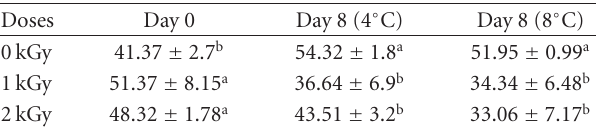
Table 1: E ff ect of E-beam treatment on the water holding capacity (WHC) of marinated pork loin following treatment and 8 days of storage at 4 and 8 ◦ C.